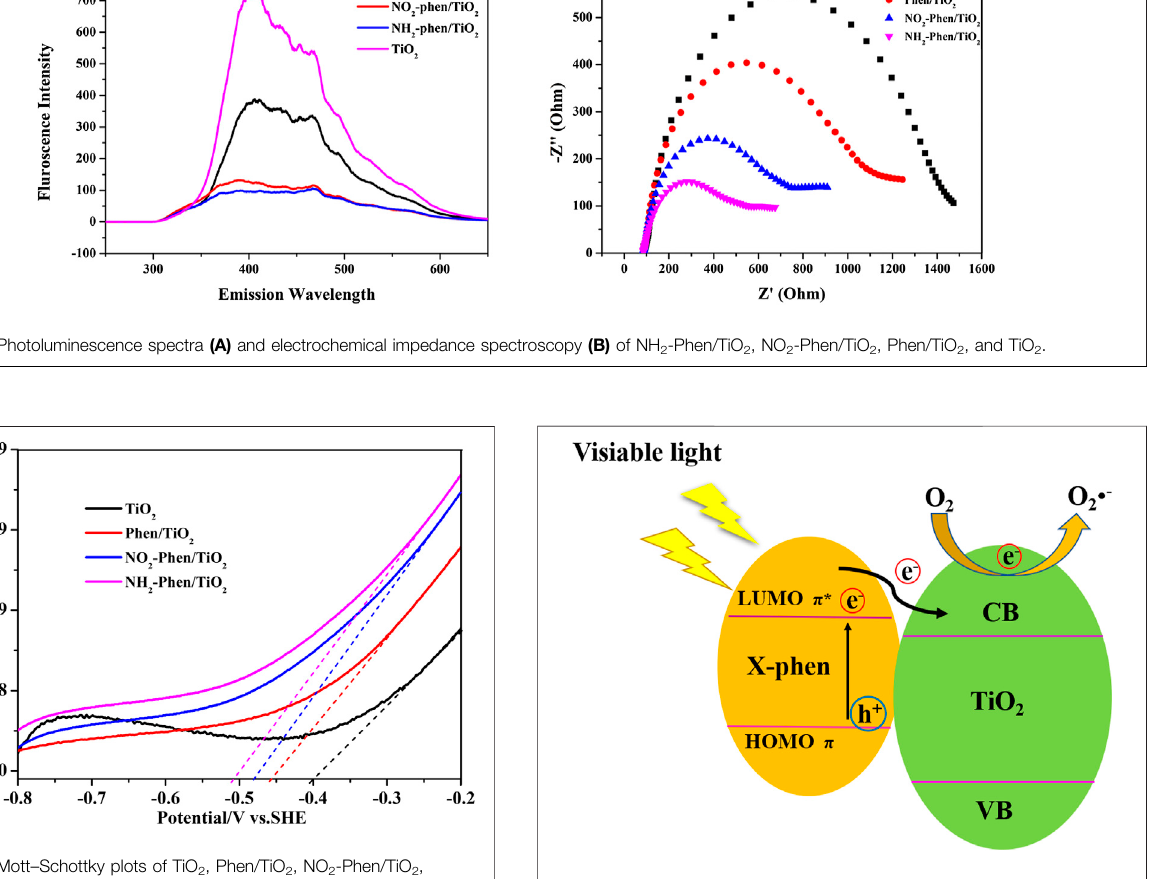
FIGURE 9 | Possible visible light photocatalytic mechanism of NH 2 -